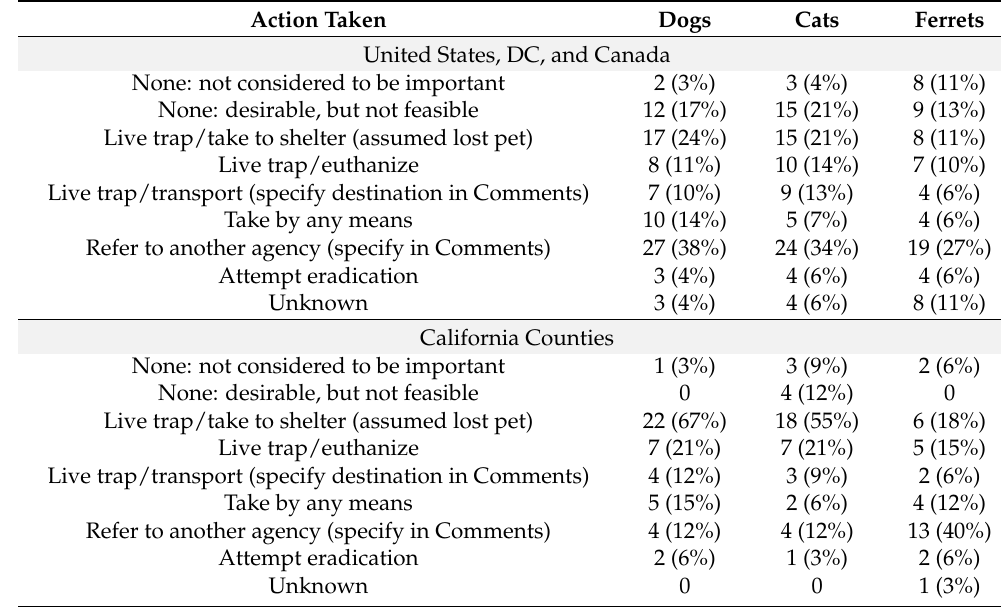
Table 6. Actions taken by agencies for unconfined dogs, cats,